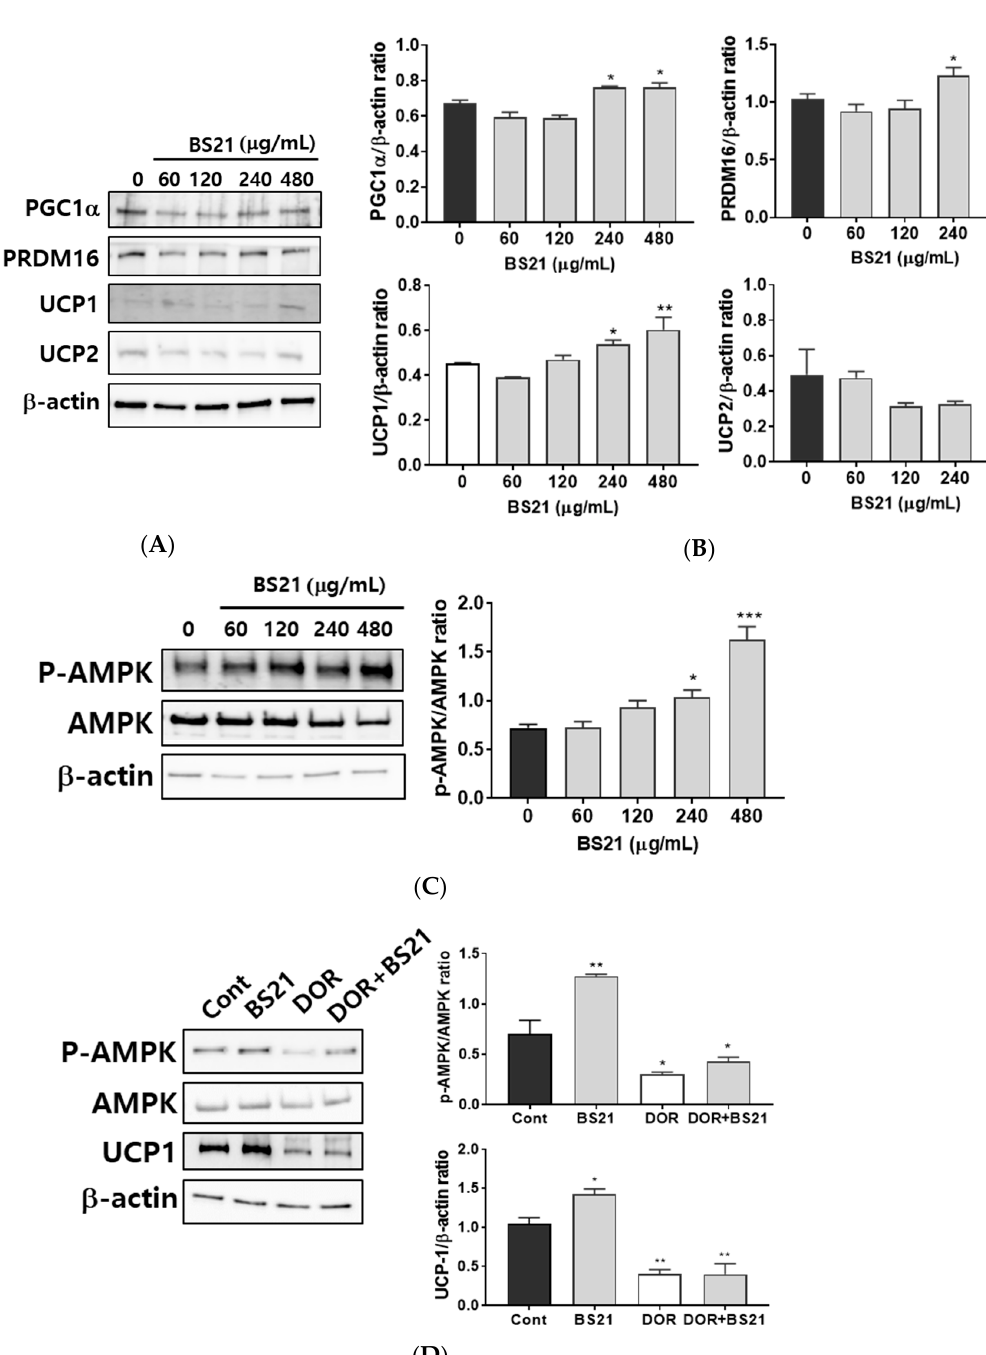
Figure 3. Effect of a 2:1 mixture of Phyllostachys pubescens and Scutellaria baicalensis (BS21) on brown adipocyte-specific protein expression and adenosine monophosphate-activated protein kinase (AMPK) phosphorylation in 3T3-L1 cells. ( A ) Representative bands and ( B ) relative changes in protein expression levels. The relative expression levels of proteins were normalized against a β -actin internal control. ( C ) Representative bands and relative changes in p-AMPK and AMPK protein levels are shown. Target-protein phosphorylation was normalized to the total protein-expression level. ( D ) 3T3-L1 adipocytes were pretreated with the p-AMPK antagonist dorsomorphin (5 µM) in addition to BS21 at differentiation stages. Values are expressed as mean ± SD ( n = 3). Significant differences were observed between differentiated MDI (3-isobutyl-1-methylxanthine, dexamethasone, and insulin) cells and BS21-treated cells: * p < 0.05, ** p < 0.01, and *** p < 0.001.